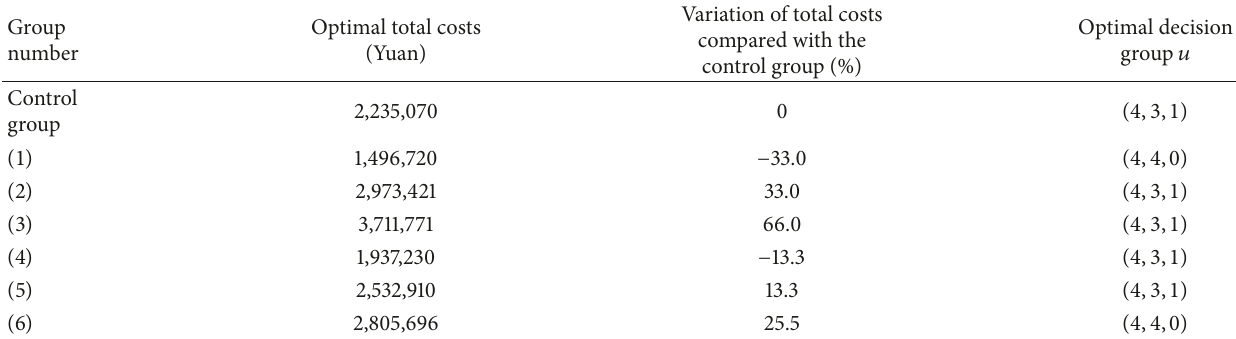
Table 5: Total costs and their variation corresponding to each